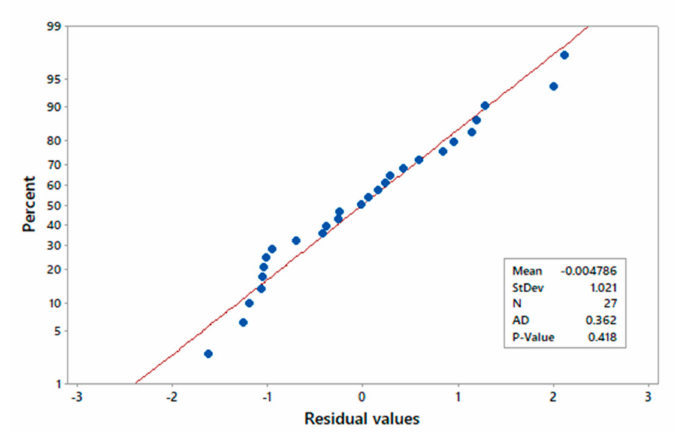
Figure 4. Probability plot of residual values.